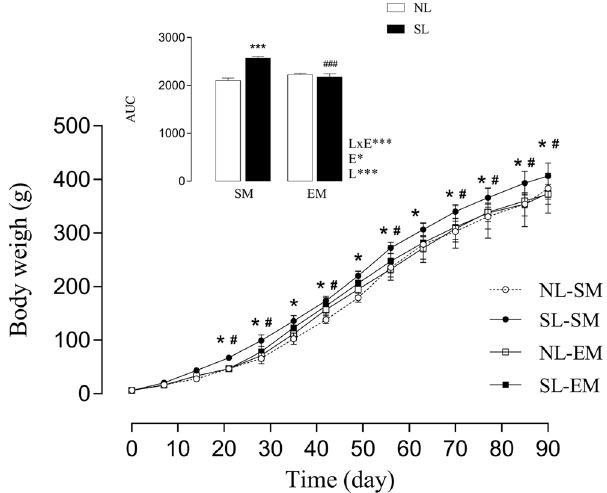
Figure 3. Effect of low intensity physical exercise training on adult offspring body weight. Area under the curve of the body weight. LxE, interaction between the exercise factor and the litter factor; E, exercise factor and L, litter factor; * p < 0.05 and *** p < 0.0001 by two-way ANOVA and Tukey’s test. (n = 6–18). The # or * represents p < 0.05 in each time points of the bw curve, was calculated by repeated measures ANOVA. Over the lines and bars, ( * ) represents NL-SM compared with SL-SM and ( # ) represents SL-SM compared to